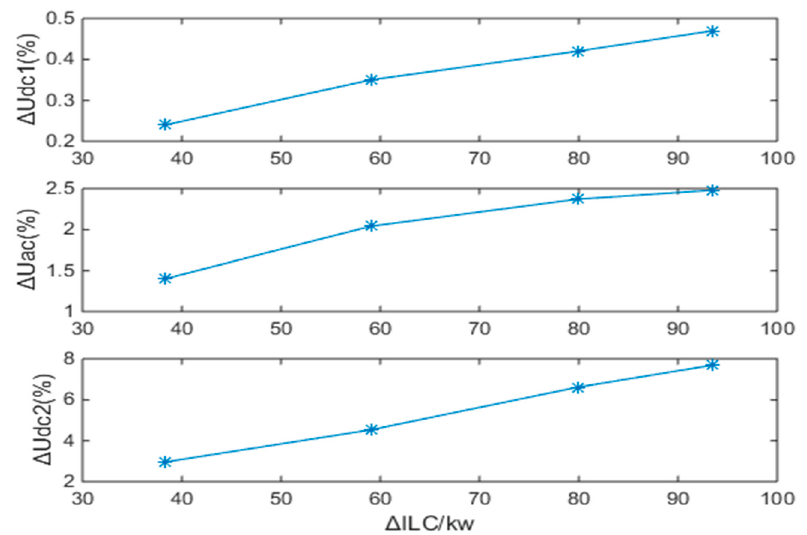
Figure 20. Maximum variation of AC and DC voltage.